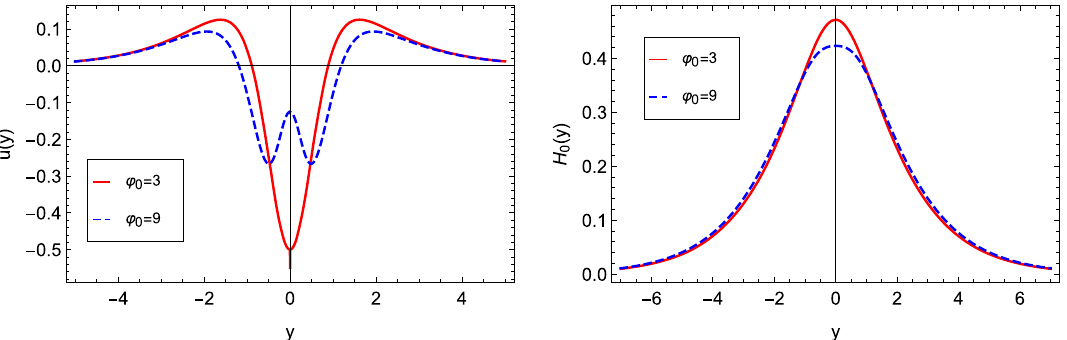
Fig. 9 Potential u ( y ) (left panel) and graviton zero mode H 0 ( y ) (right panel) for the solutions described in Sect. 3.3 with V 0 = 1 and ψ 0 = 1. Depending on the choice of ϕ 0 , the potential U might be a single or a double well. The finiteness of the integral of H 0 implies that the zero graviton mode is